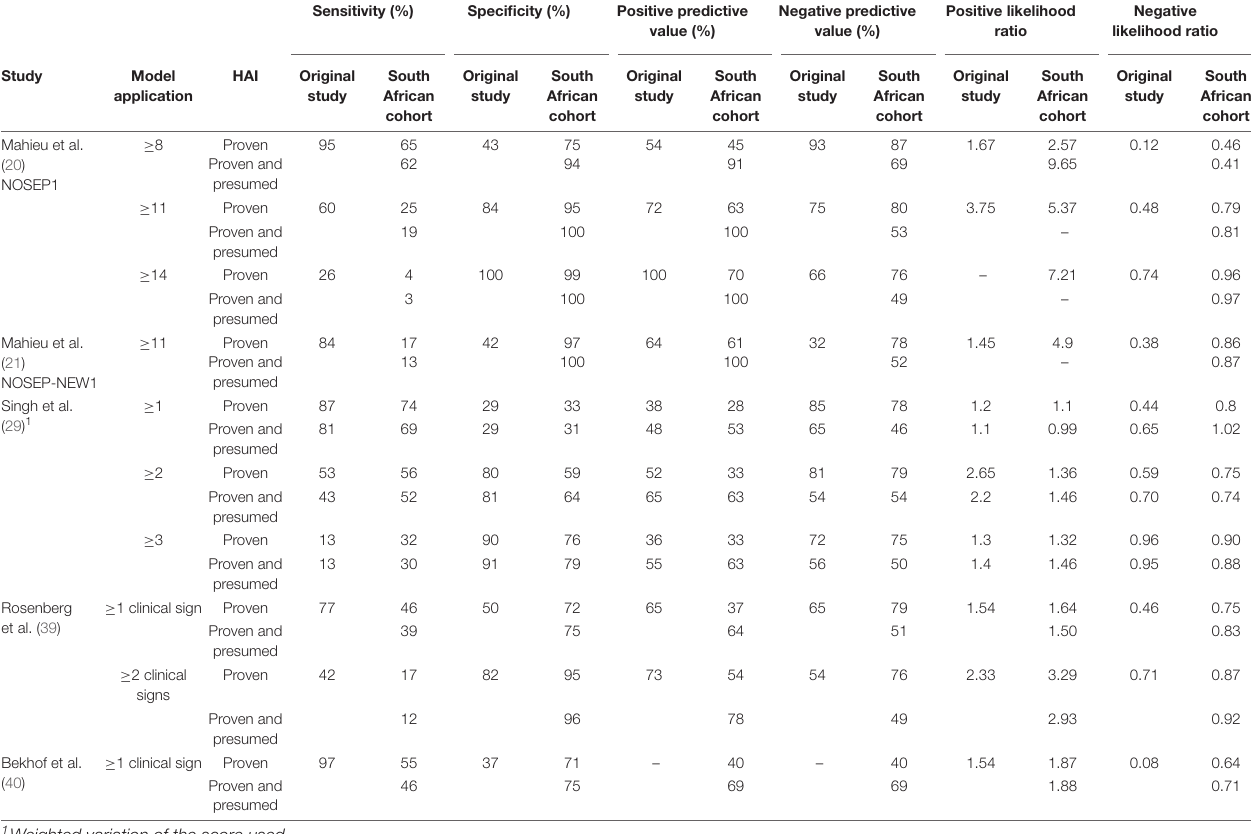
Sensitivity (%) Specificity (%) Positive predictive